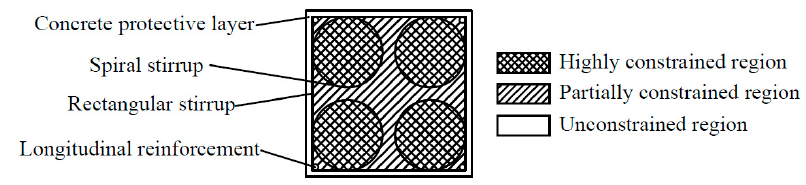
Figure 8. Division of constrained region of square column with four spiral stirrups.